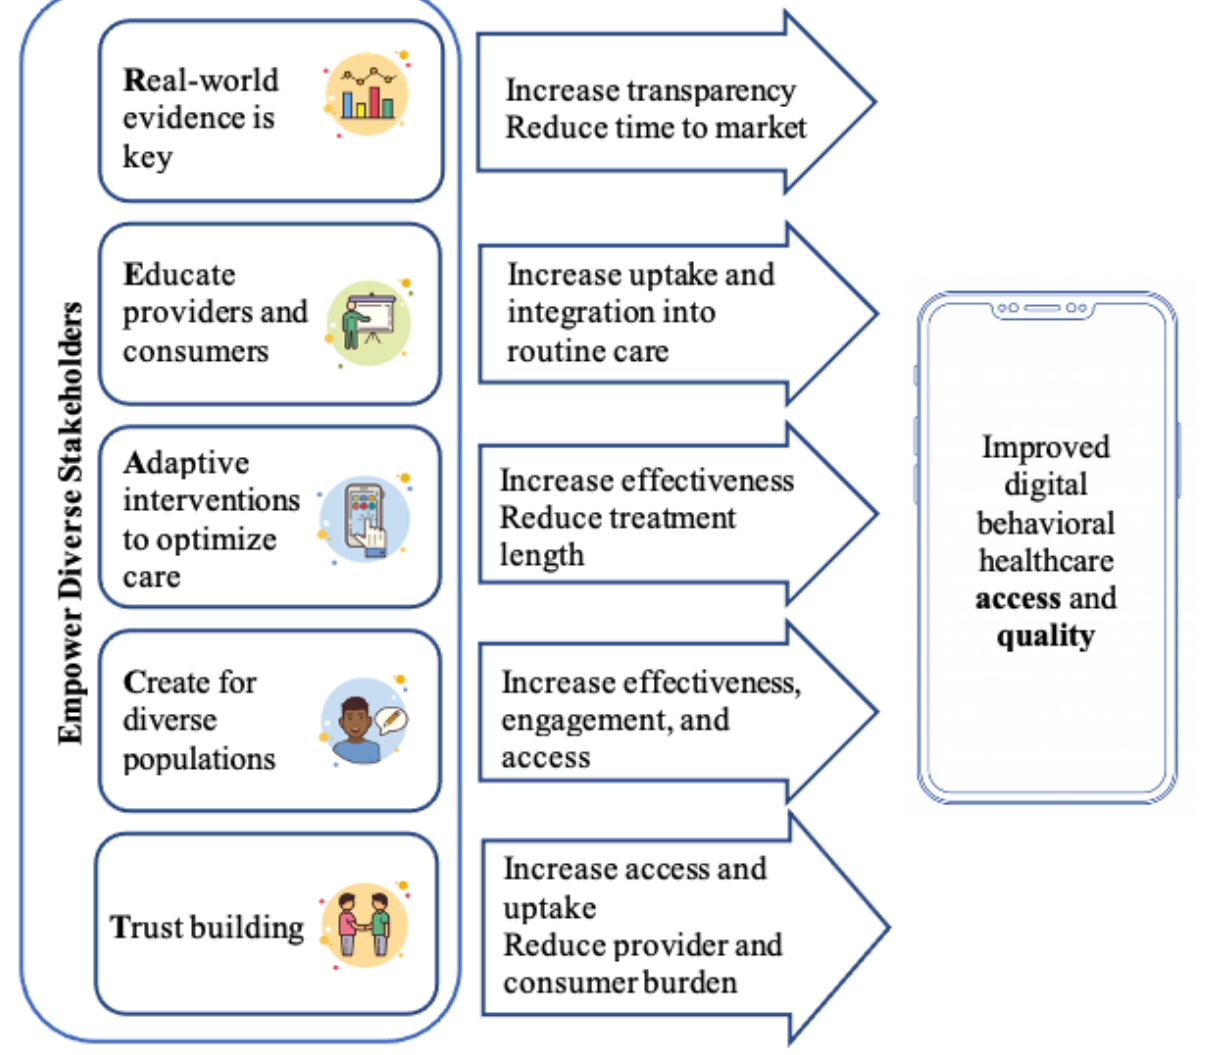
Figure 1. Ecosystem-wide recommendations to increase digital mental health access and